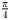
Examples of axonal morphologies generated by the model and comparison to real data.(A) Real (left) and simulated (right) axonal trees of zebrafish retina ganglion neurons. (B) Real (left) and simulated (right) axonal trees of human neocortex pyramidal neurons. Real axonal trees were obtained from the Neuromorpho.org database. Simulated axons where generated in isolation, using the following parameter values (Zebrafish/Human): for the main axon α = 15/10 and β = 2/30; for the branches α = 20/100 and β = 0.5/10, Δρ = 1/3, ψ = 0 rad ∀x / 0 rad. for x ≤ 60 μm, +(−)1.3 rad for x > 60 μm and y > 0(y ≤ 0), Pb = 0.5/0 for x < 60 μm and 0.3 otherwise, ω: uniform in all the space/ uniform in a solid angle of π4 respect to the neurite from which the branch emerges, λb = 6/1, bl = 2/2, nmax = 10/1, Xmax = 80/110. In addition, for the human neocortex pyramidal neurons, branch maximum lengths follow a normal distribution of mean 100 μm and standard deviation 70 μm.